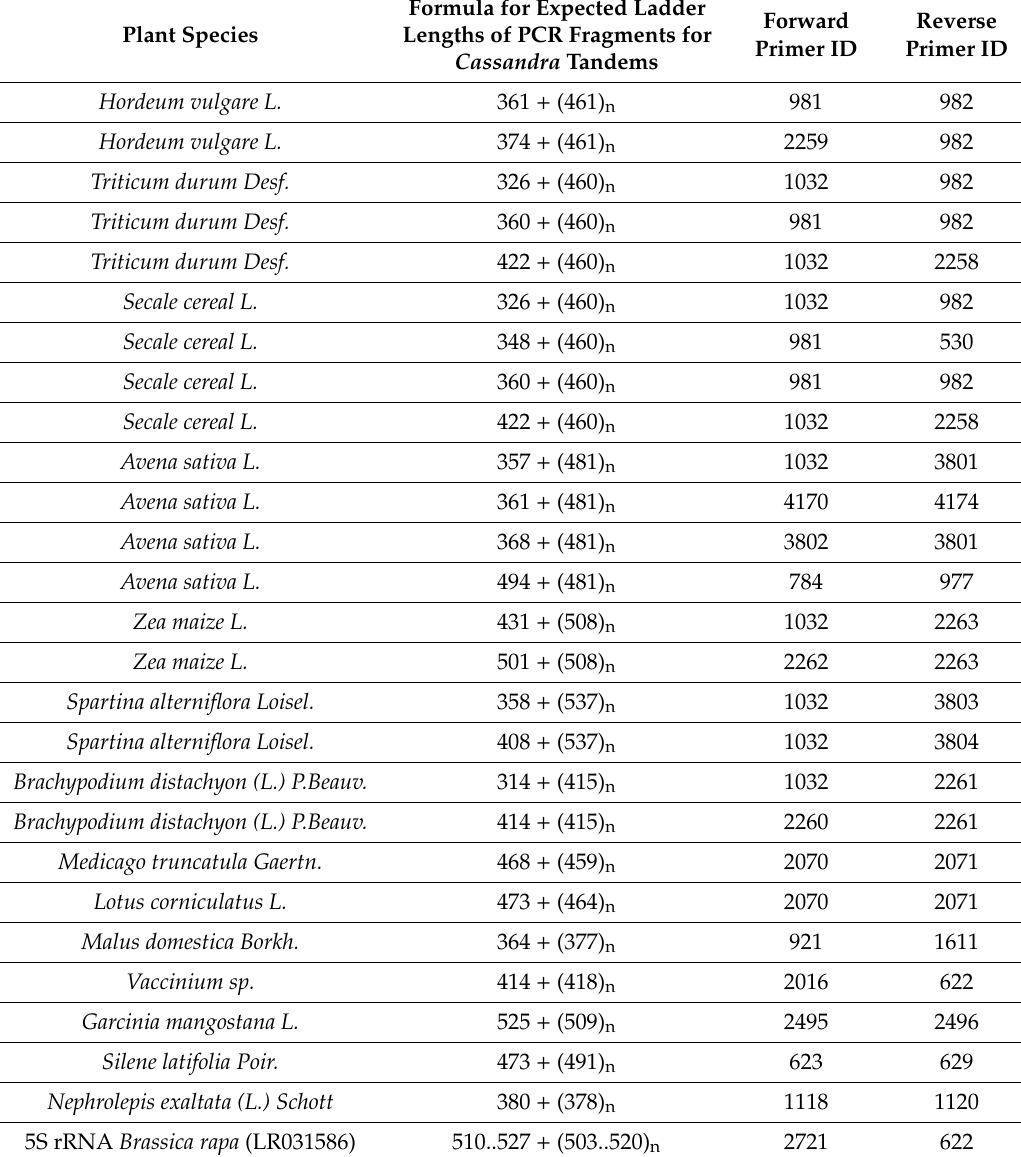
Table 2. In silico PCR prediction for PCR fragments lengths for Cassandra tandem arrays in various plant